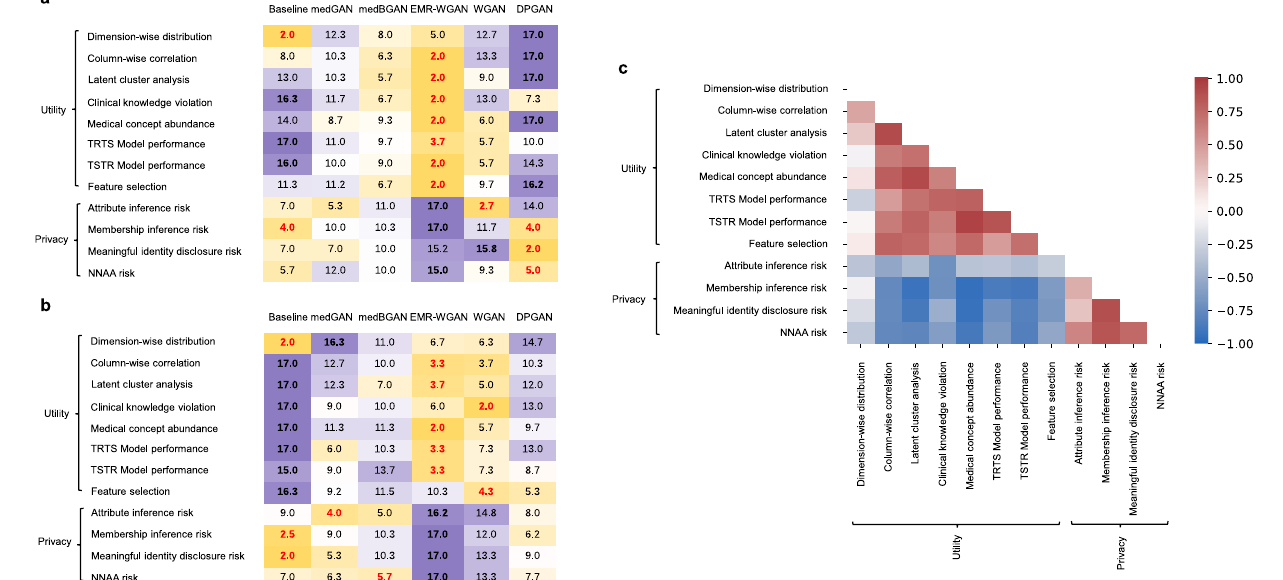
correlation coef fi cients for pairwise metrics on the rank-derived scores across all candidate models for the two real datasets (UW and VUMC). The best (i.e., lowest rank) and worst scores for each metric are inbold red and black font, respectively.